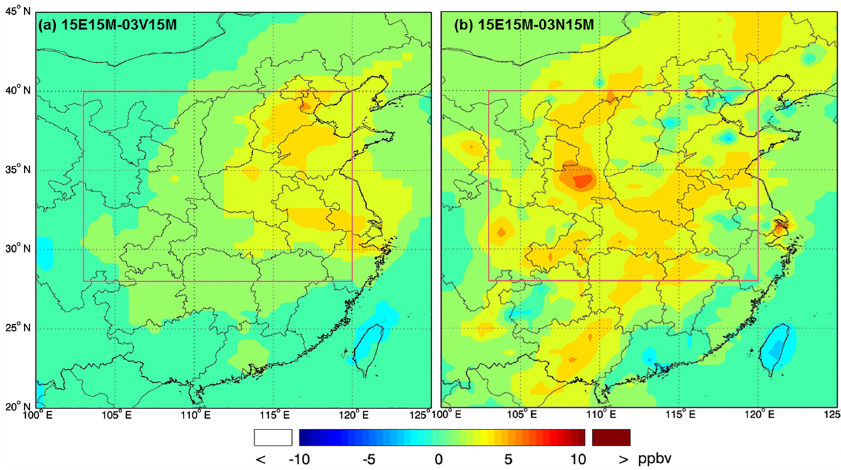
Figure 6. Effects of anthropogenic NMVOCs (a) and NO x (b) emission changes on surface MDA8 O 3 concentrations between 2003 and 2015 when other emissions and meteorological parameters are fixed at 2015